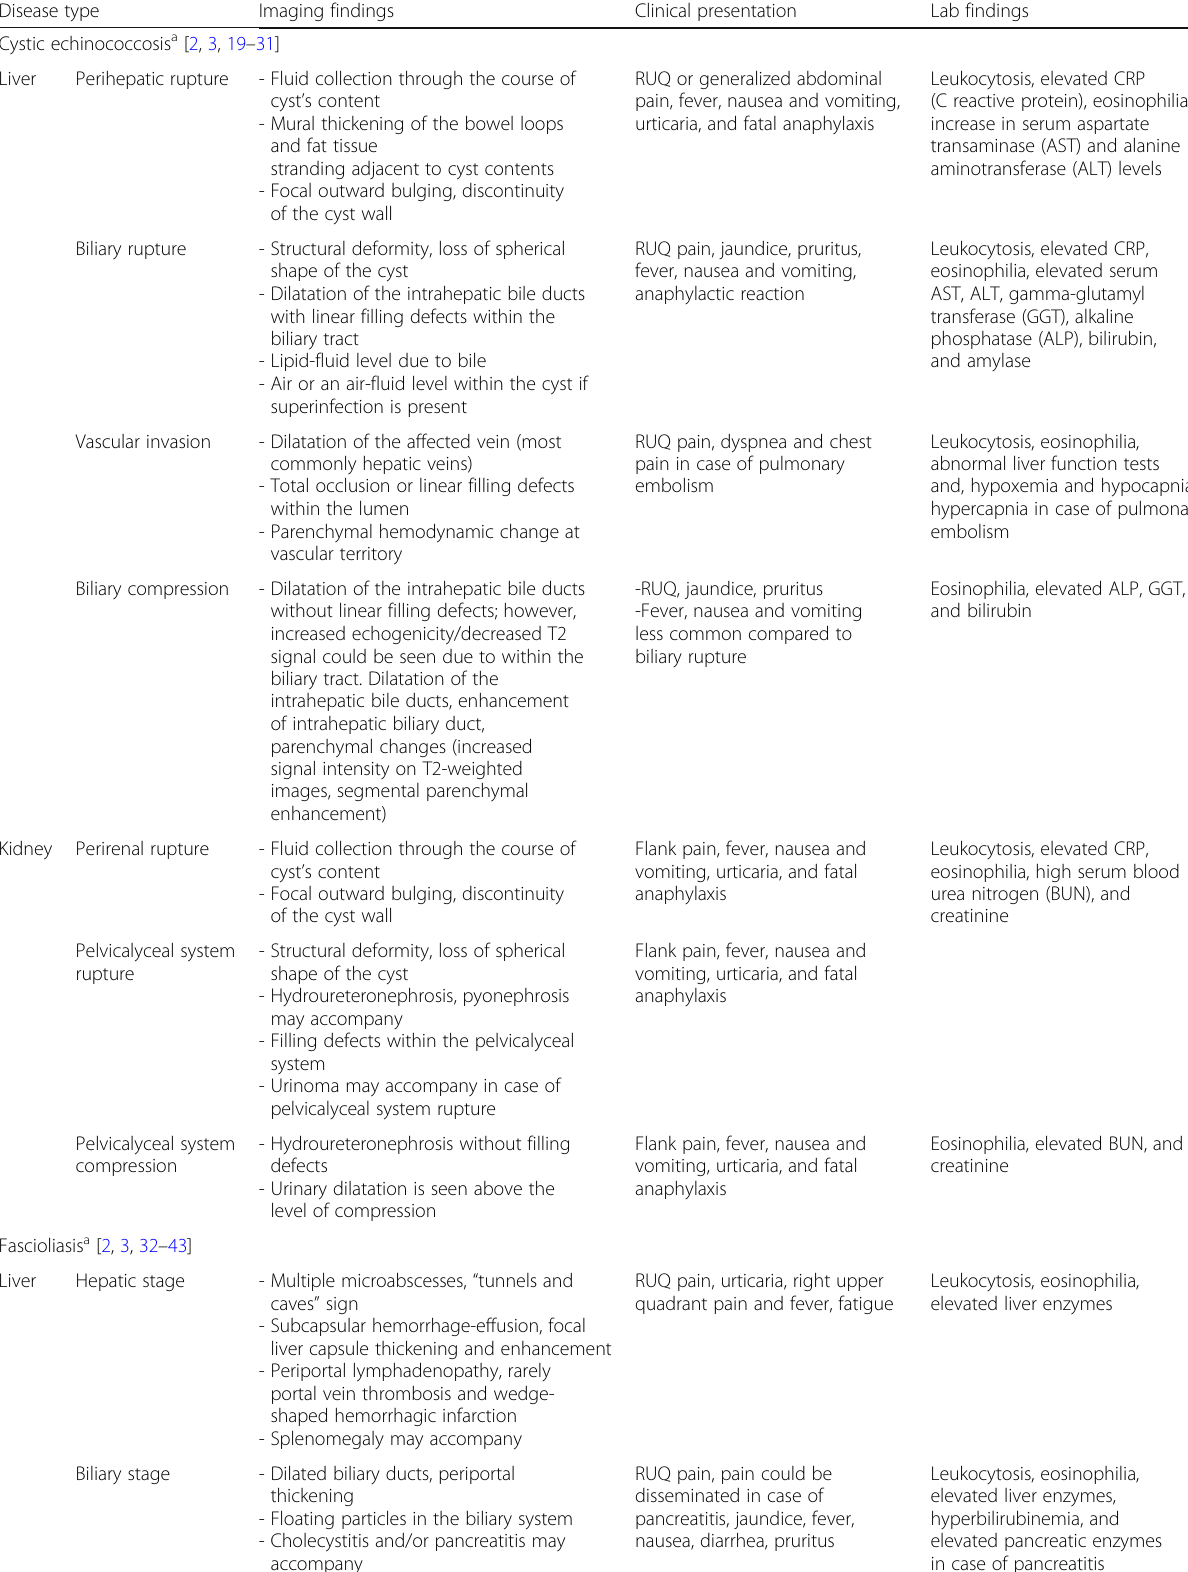
Table 2 Parasitosis and affected abdominal organs. Associated radiological, clinical, and laboratory findings Disease